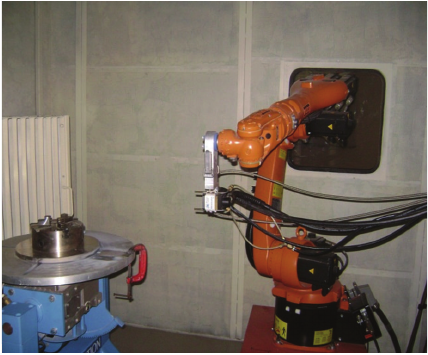
Figure 1: 80 kW atmospheric plasma spray